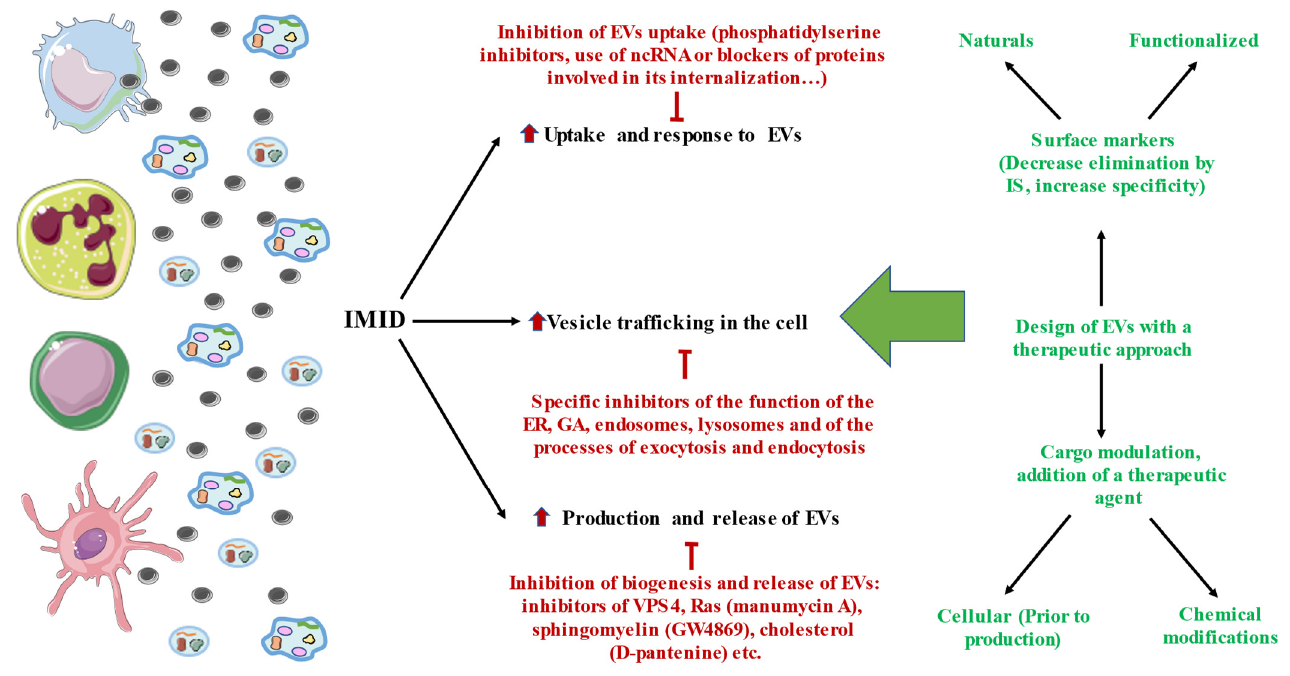
Figure 2. Overall summary of the therapeutic strategies currently pursued to limit the influence of high cellular traffic, production, release, and uptake in the IS. There are different approaches aimed at cell trafficking and its organelles, as well as at EVs, with some promising but still preclinical results. On the other hand, researchers are also beginning to design EVs that can be used for therapeutic purposes. In these cases, it is important to try to ensure their specificity and avoid their elimination by cells of the IS, so the selection of their membrane components should be oriented to this end. In the same way, modulating their contents and even adding a specific therapeutic agent could bring multiple benefits to the clinical management of IMIDs. For this, different approaches are being evaluated, such as modifying their content before their production (at the cellular level) or after being released by the cells, through chemical modifications.